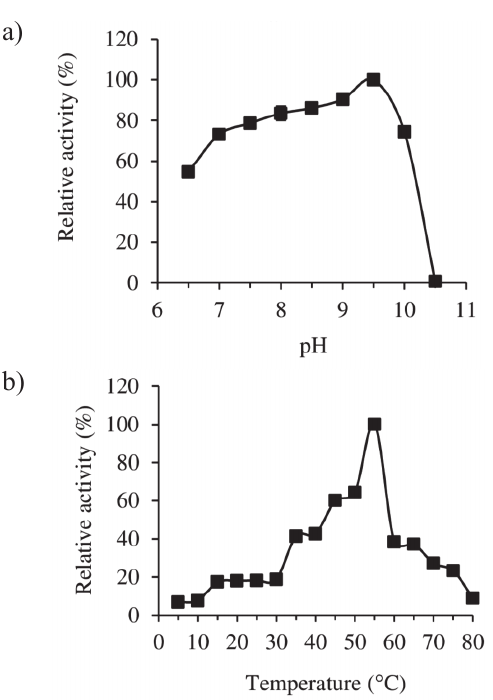
Fig. 4 – Effect of pH and temperature on the activity of li- on the activity of lipase from Anoxybacillus sp. Fig. 4 Effect of pH and temperature pase from Anoxybacillus sp. HBB16 a) The effect of pH on the HBB16 a) The effect of pH on the activity of the lipase. The lipase was incubated with activity of the lipase. The lipase was incubated with substrate substrate (triolein) at various pHs at 55 °C b) The effect of temperature on the activity (triolein) at various pHs at 55 °C b) The effect of temperature of lipase. The lipase was incubated with substrate (pNPL) in 50 mMTris-HCl buffer on the activity of lipase. The lipase was incubated with sub- (pH 8.0) at various temperatures. All of the measurements are the means of three strate (pNPL) in 50 mm Tris-HCl buffer (pH 8.0) at various experimental data sets. temperatures. All of the measurements are the means of three experimental data